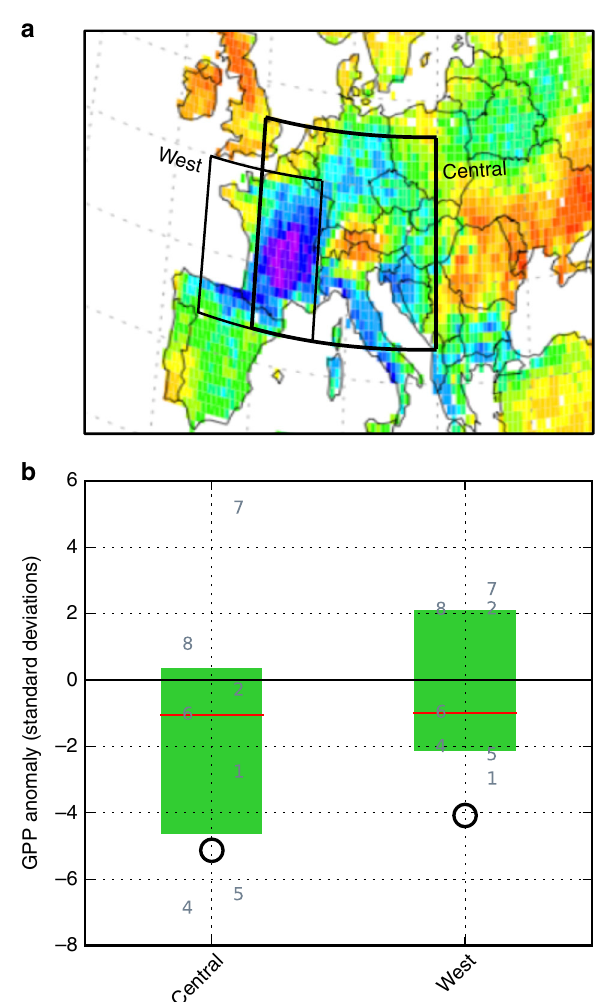
Fig. 4 Summer (June – August) gross primary productivity (GPP) anomaly in 2003. a Outlines of the West and Central regions, overlaid on a map of the observed GPP anomaly; see Supplementary Fig. 10 for a more detailed version of this map. b Regionally averaged anomaly. Black circles show MODIS remote-sensing-derived estimates. Grey numbers are the global vegetation models; numbers offset to the left represent models that were run without considering any human in fl uence except climate change, while numbers offset to the right represent models that accounted for historical land-use patterns and, in some cases, anthropogenic water withdrawal. Red lines indicate the median, and green boxes the interquartile range, of the model ensemble. One model (no. 4) did not report total GPP but only GPP for individual plant functional types (PFTs); for this model, we show the sum of the four dominant PFTs in the relevant zero values (Fig. 4b, numbers). There is no systematic difference between models that include and exclude human- induced changes to the natural vegetation pattern (land use change). The estimates are largely insensitive to the choice of climate forcing data set (Supplementary Fig. 11), despite substantial differences in annual shortwave radiation between data sets 49 .